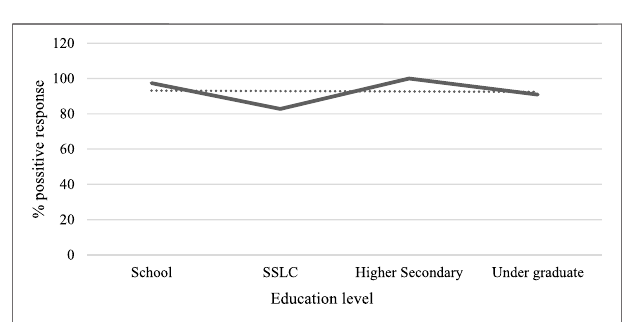
FIGURE 6 | Education Level vs. Outlook towards